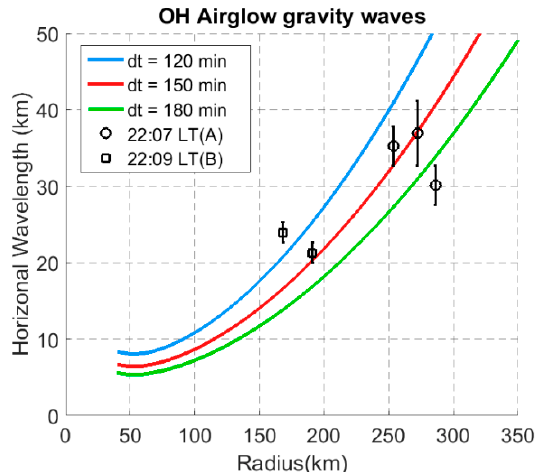
Figure 4. Temporal and spatial horizontal wavelengths variations measured by the all-sky imager at 22:07 LT and 22:09 LT on 10th August.